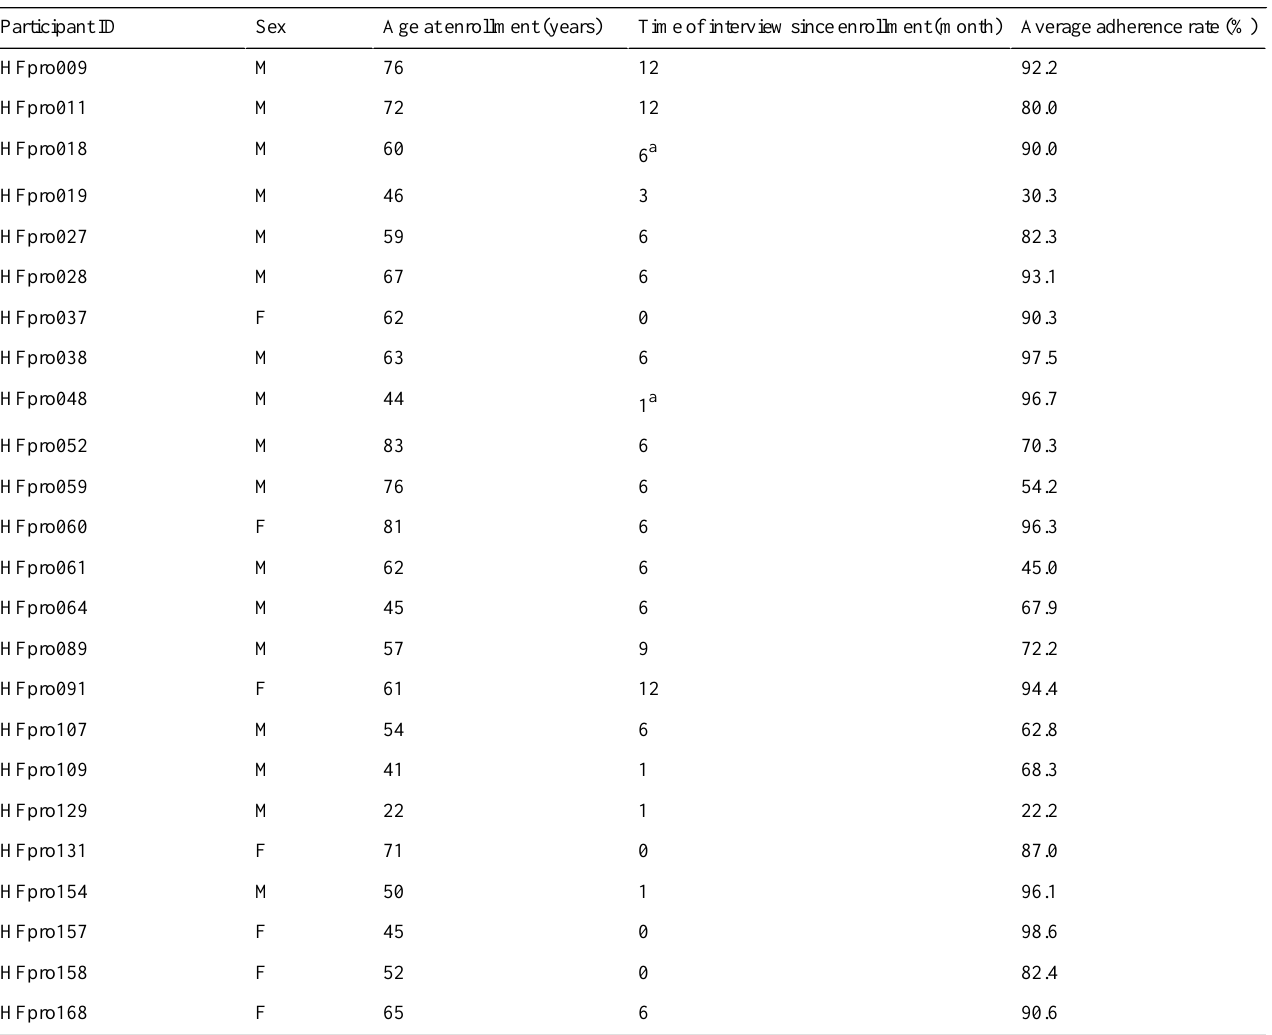
Table 5. Participant characteristics for semistructured